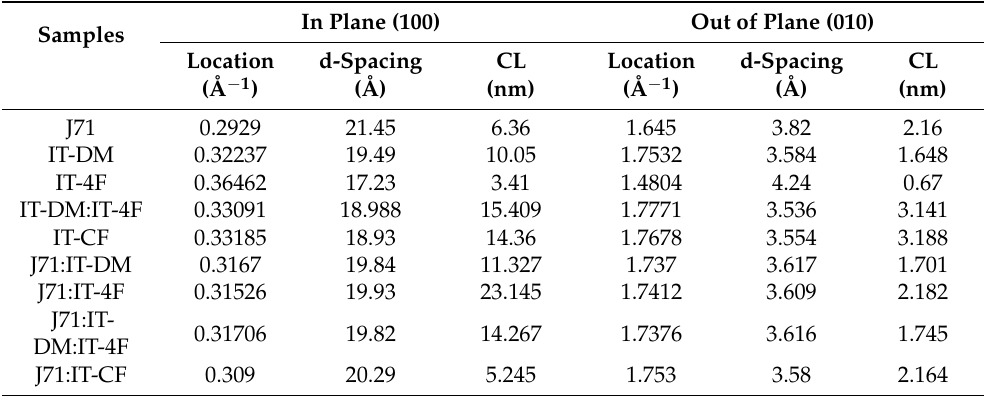
Table 1. Packing parameters for the pristine donor and acceptor films as well as the active blend films based on the GIWAXS